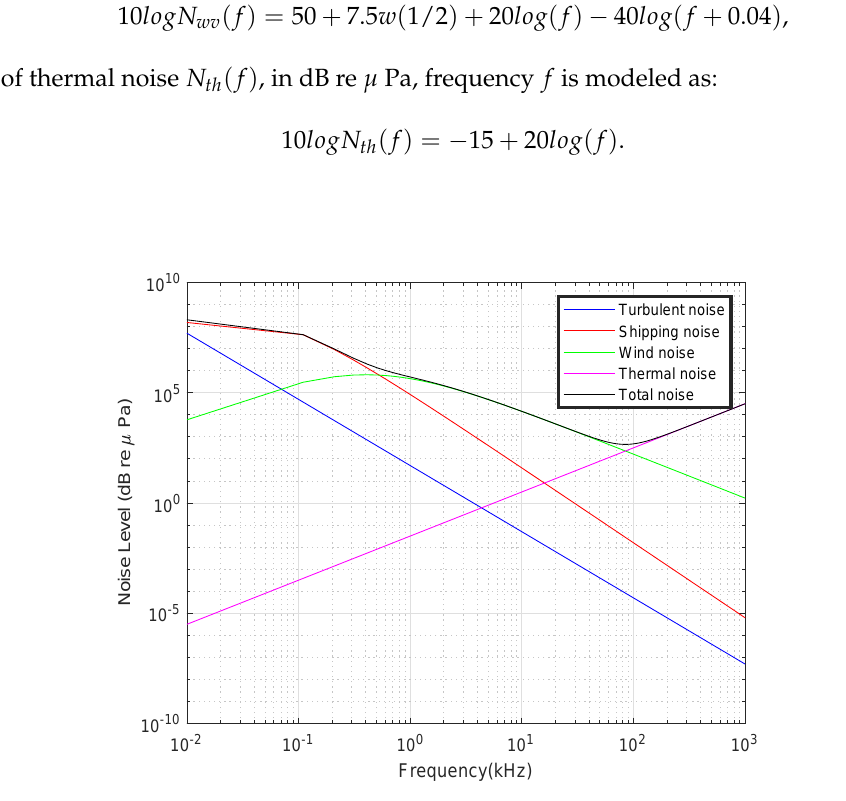
Figure 3. Ambient noise (dB re µ Pa) level in seawater.